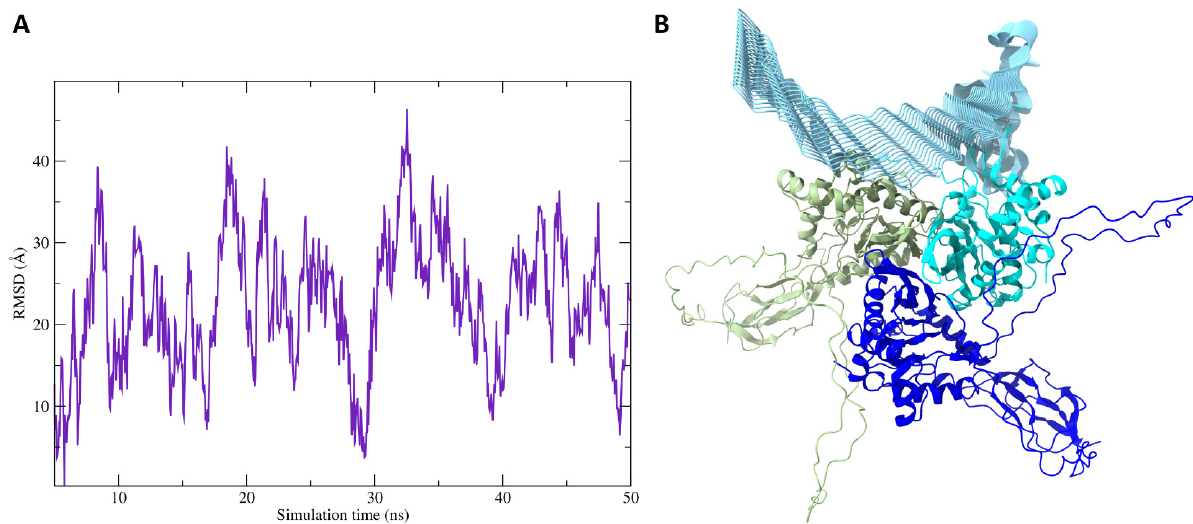
Figure 3. ( A ) The root-mean-square deviation (RMSD) of the hE2o Lys 43 C α in the course of 50 ns MD simulation. The system became stable in the first 5 ns. The reference structure in the RMSD calculation was the 5 ns structure. ( B ) Molecular motions of the N-terminal region in hE2o (residues 78–133) as deduced from the first normal mode analysis (NMA). A quantitative assessment of flex- ibility and the extent of molecular motions of the N-terminal region was obtained through 50 ns of MD simulation. The hE2o chains are depicted in blue , green , and cyan with motions being shown for the cyan chain only.